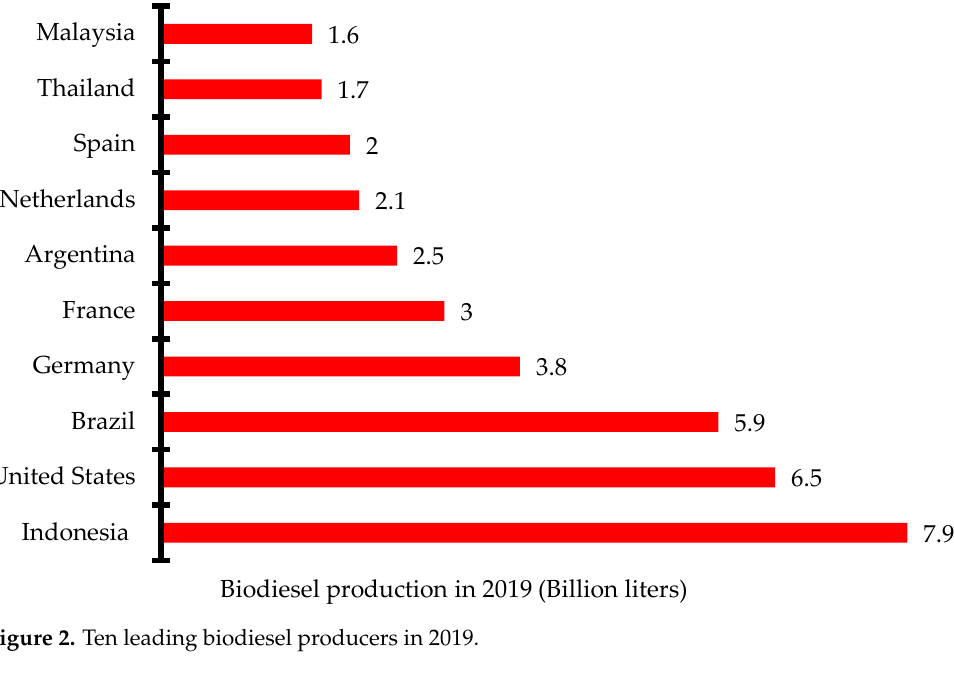
Figure 2. Ten leading biodiesel producers in 2019.